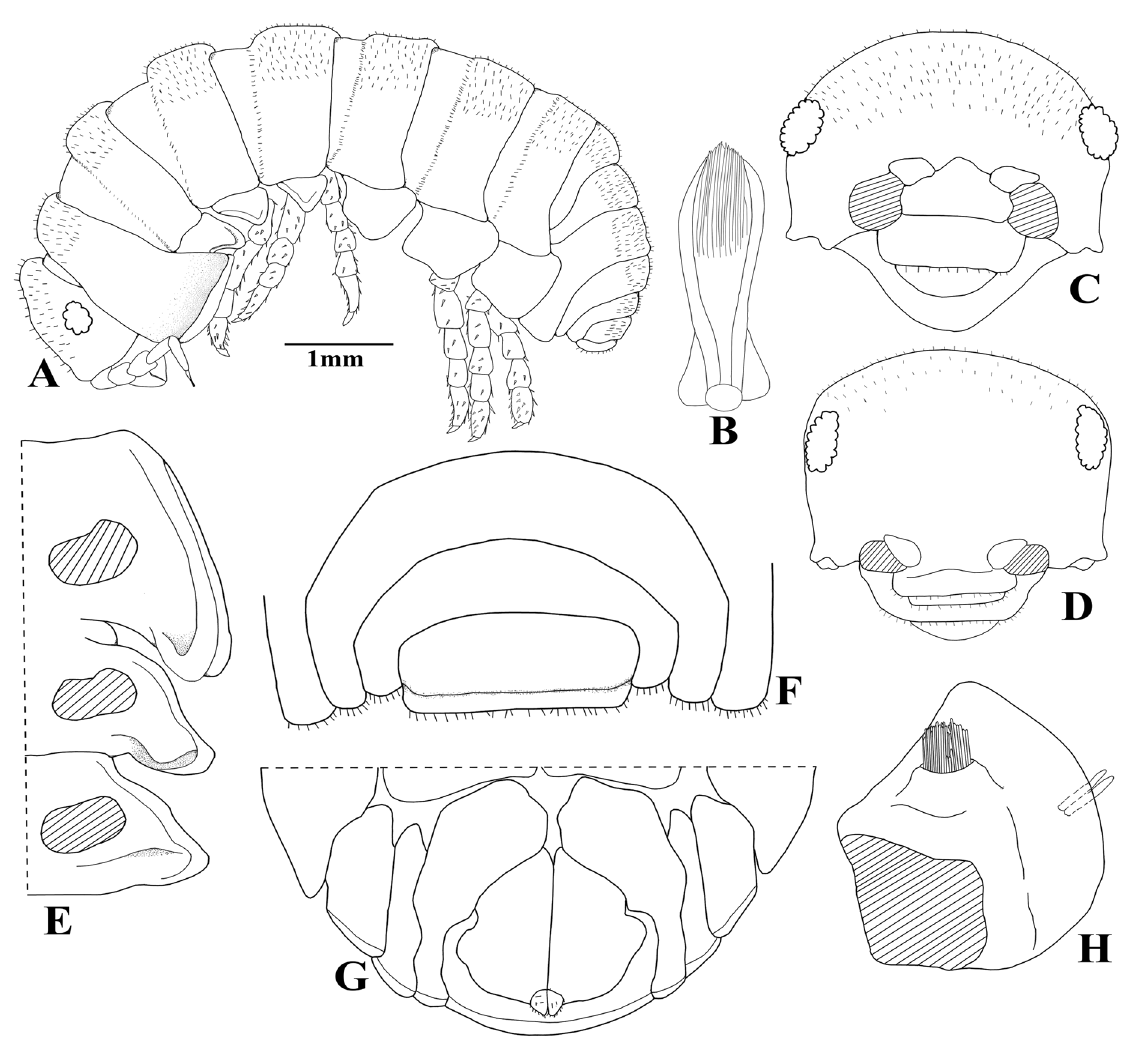
Fig. 3. Tylos negroi López-Orozco, Carpio-Díaz & Campos-Filho sp. nov., paratype, ♂ (CDUC- CRU 128). A . Habitus, lateral view. B . Dorsal scale-seta. C . Cephalon, frontal view. D . Cephalon, dorsal view. E . Epimera of pereonites 1–3, ventral view. F . Pleonites 4, 5 and telson, dorsal view. G . Pleon, ventral view. H .